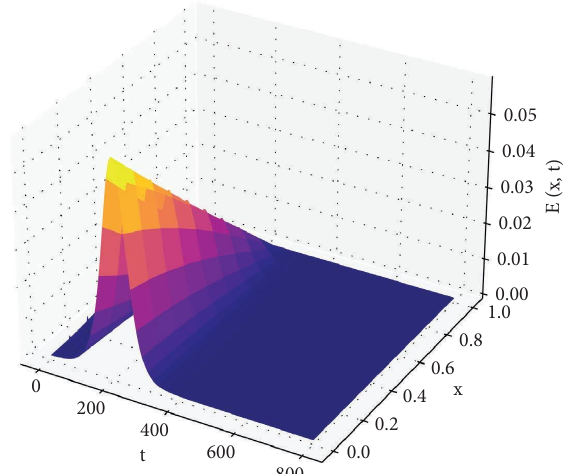
Figure 3: A 3-dimensional plot for the proportion of exposed in space and